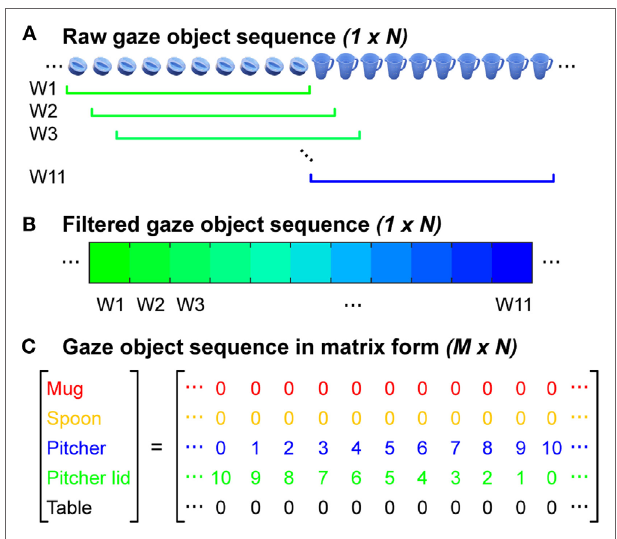
FigUre 6 | (a) Each raw gaze object sequence was represented by a (1 × N ) set of frames. In this example, the gaze object transitioned from the pitcher lid to the pitcher. The colors in the figure correspond to the color-coded objects in Figure 1c . (B) The raw sequence of gaze objects was filtered using a rolling window of 10 frames. (c) The gaze object sequence was represented by an ( M × N ) matrix for M task-relevant objects.